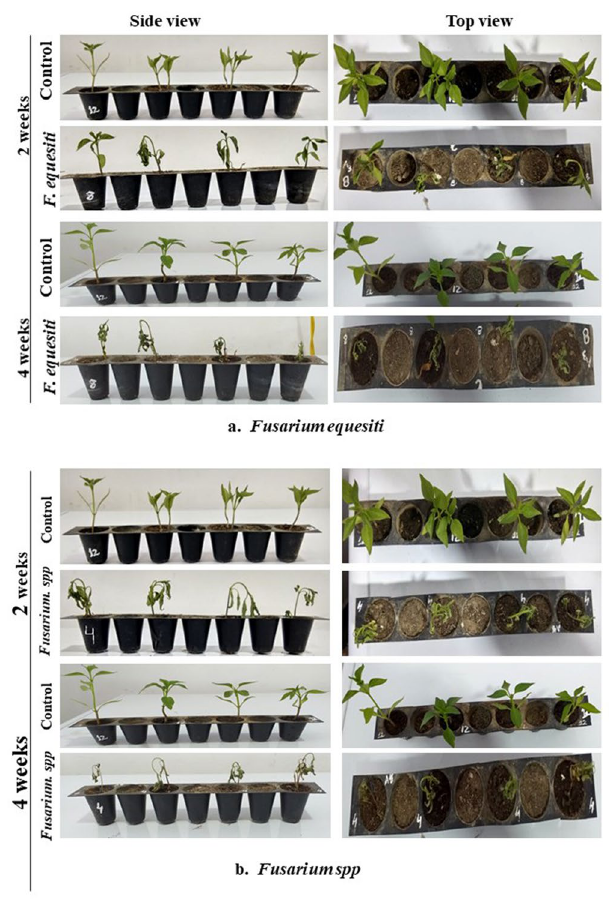
Figure 6. ( a ) Pathogenicity test of isolated Fusarium equiseti on potted chilli plants. ( b ) Pathogenicity test of isolated Fusarium sp. on potted chilli